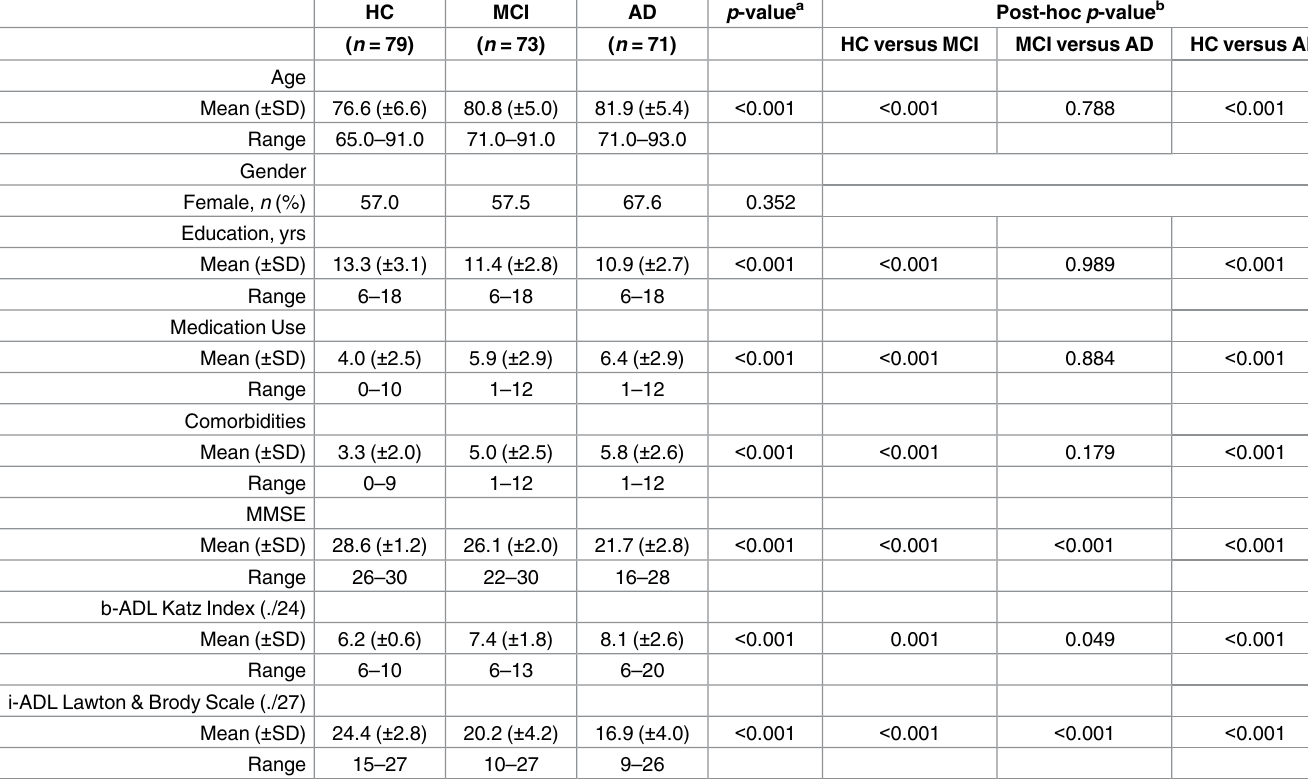
Table 5. Participants’ characteristics.